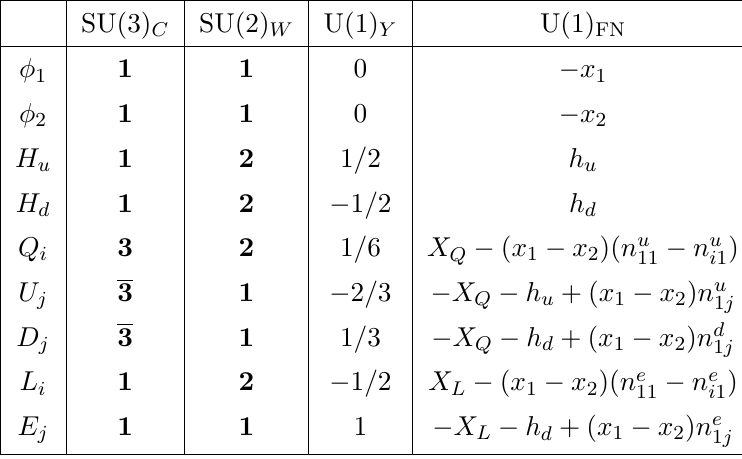
Table 1 . Gauge charges of the singlet and MSSM (cid:12)elds. X Q (cid:17) q Q X L (cid:17) q L the U(1) FN charge of L 1 1